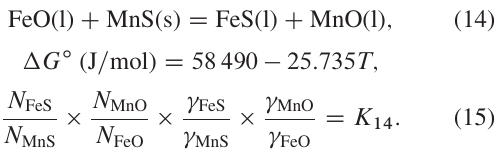
Figure 11. Effect of P O Mn = Fe in matte and